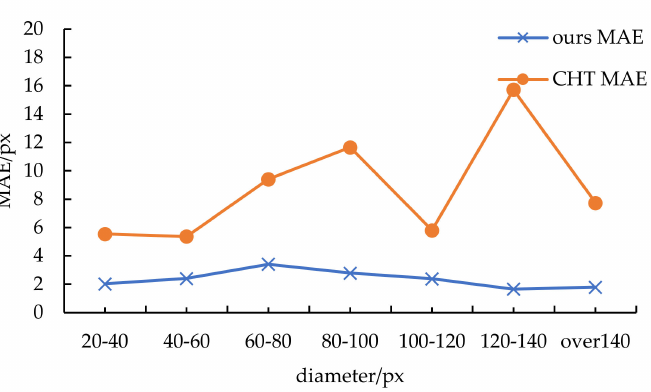
Figure 15. Fitting effect comparison of the proposed algorithm (ours) and CHT.